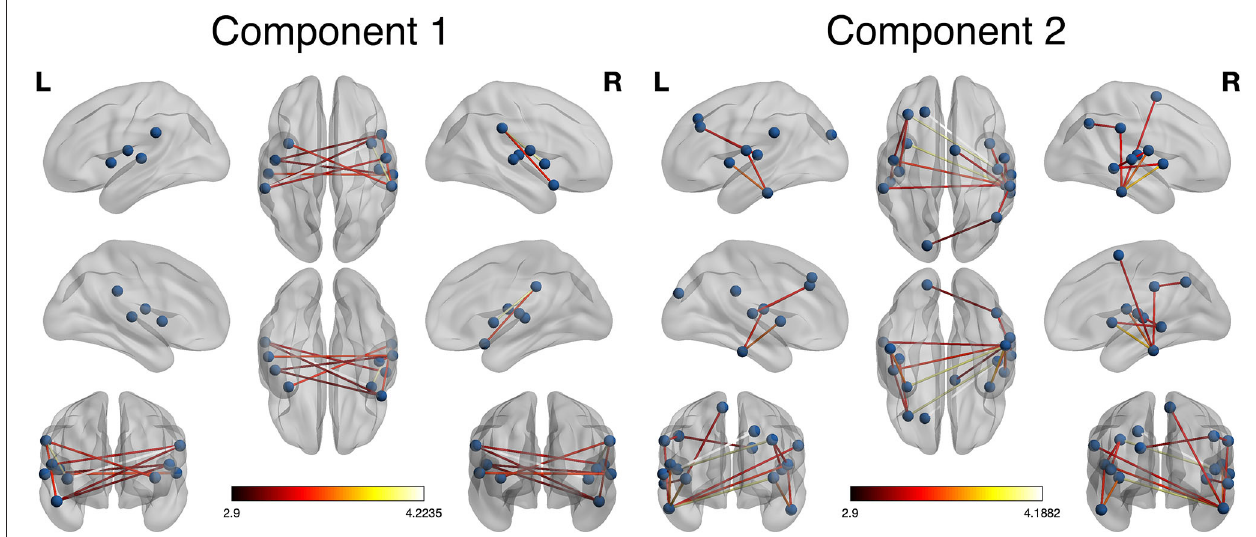
FIGURE 1 | Network-based statistic (NBS) visualization. Two components were identified by NBS that differed significantly between groups. Component 1 included connections among lateral temporal and parietal regions. These connections were hypo-connected in the POST-TX compared to the PRE-TX group (colorbar indicates t statistic, p = 0.042, FWE corrected). Component 2 included connections in the frontal, temporal, parietal, and occipital regions. These connections were hyper-connected in the POST-TX group (colorbar indicates t statistic, p = 0.006, FWE